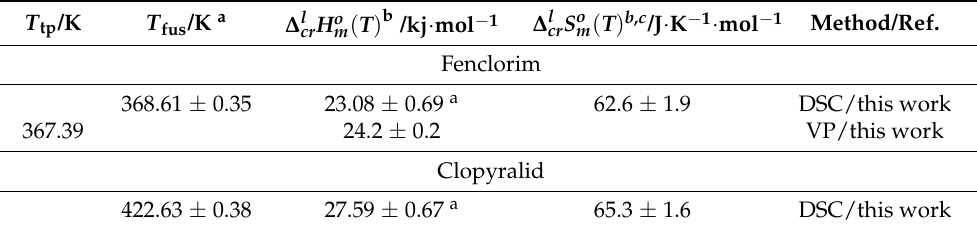
Table 5. Fusion properties: temperature, molar enthalpy and entropy of the compounds studied. T tp